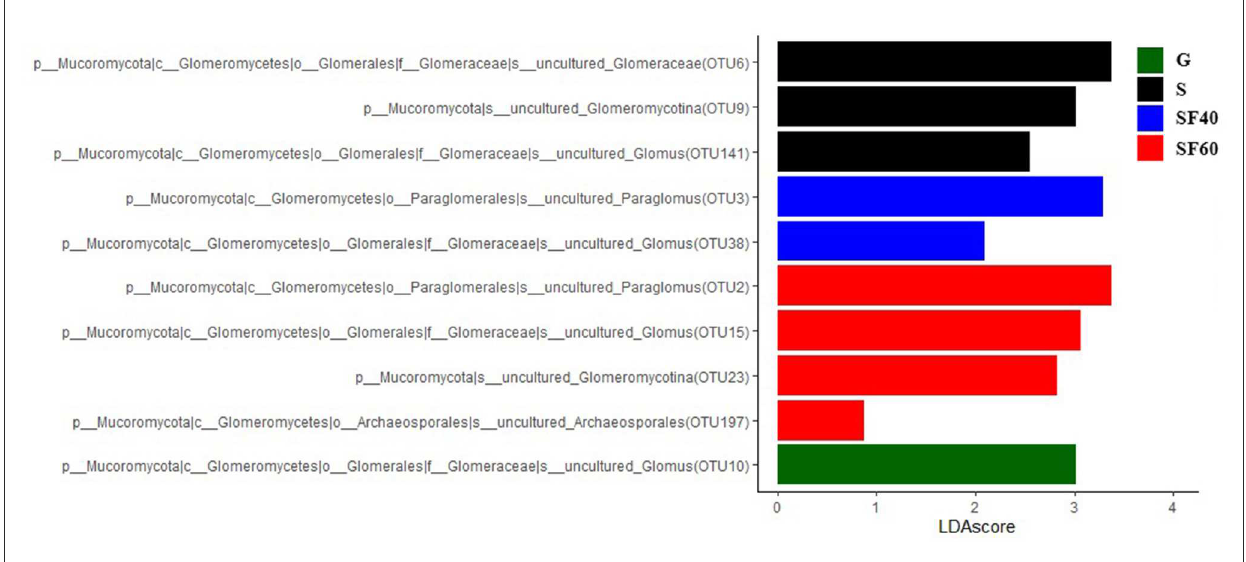
FIGURE5 The LEfSe of soil AMF communities along successional stages. G: grasslands; S: shrubs; SF40: secondary forest of 40a; and SF60: secondary forest of 60a.